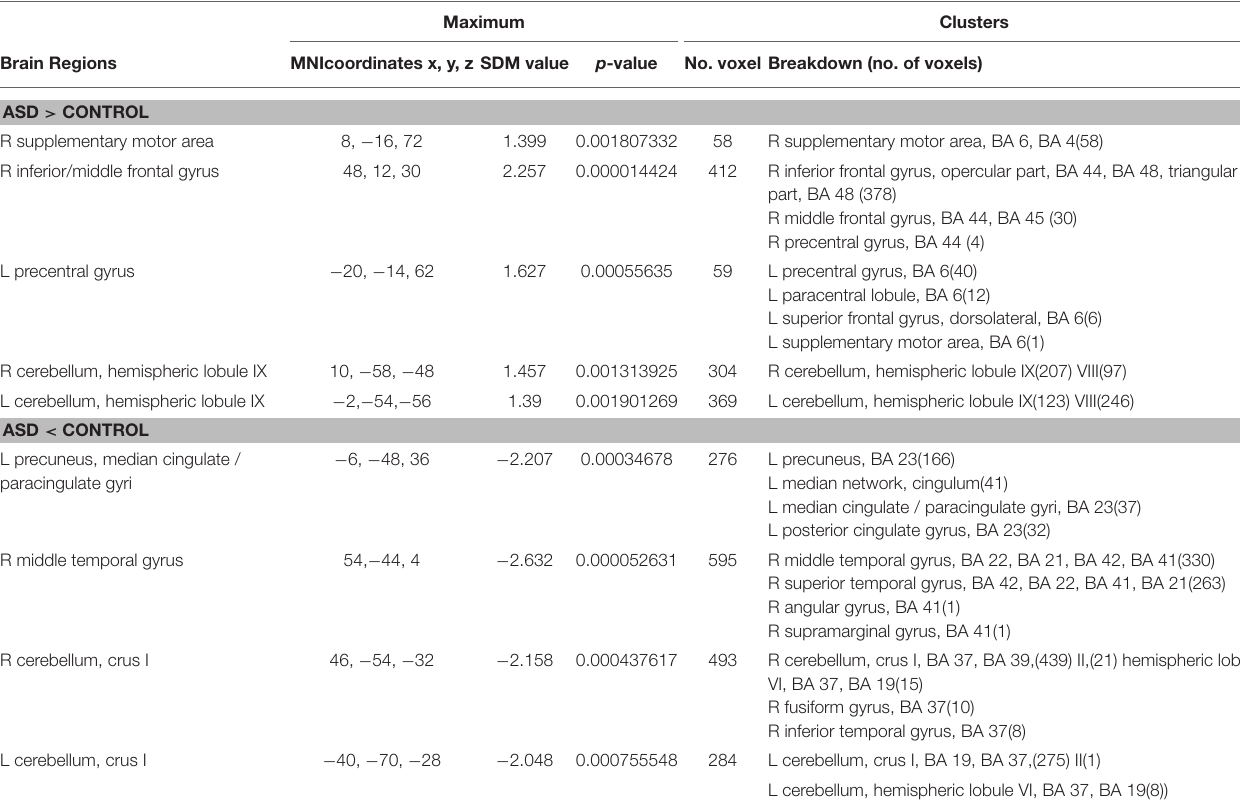
TABLE 2 | Brain regions showing greater and less activity in patients with ASD and healthy controls in the pooled meta-analysis (voxel-wise p < 0.005 and full-width at half-maximum 20mm). Maximum Clusters Brain